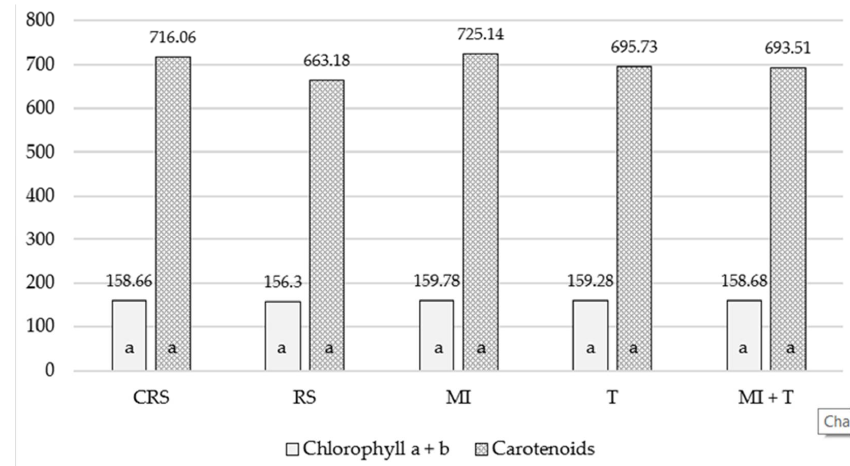
Figure A1. The leaf chlorophyll content (mg kg − 1 ) in the apple trees (CRS = crop rotation soil; RS = replanted soil; MI = mycorrhizal inoculum; T = Trichoderma; MI + T = mycorrhizal inoculum + Trihoderma ). Each parameter was individually analyzed statistically. Means marked with the same letters do not differ significantly at α = 0.05.